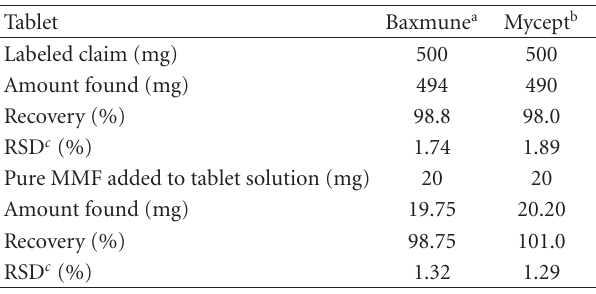
Table 3: Results of analysis of MMF in pharmaceutical samples.